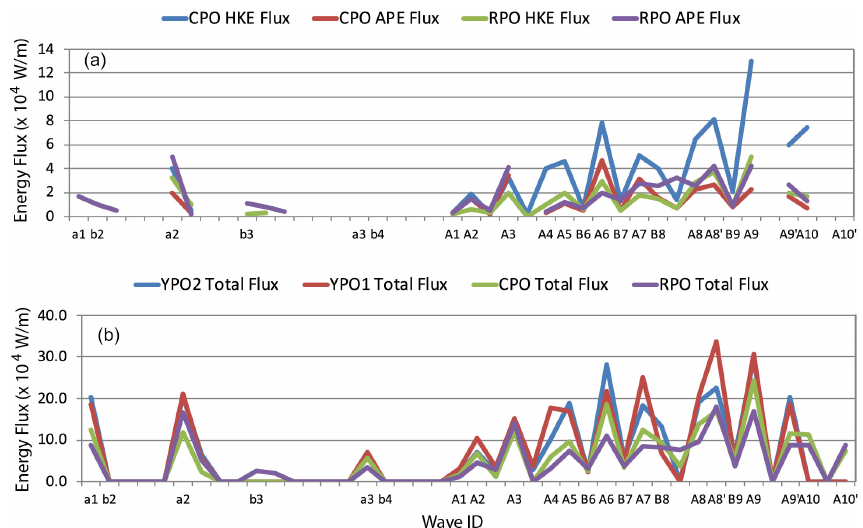
Figure 16. The energy fluxes up the slope for each of the nonlinear internal waves identified in the sand dunes moored array data. (a) The kinetic and potential energy flux for moorings CPO and RPO. (b) The total energy flux for all four moorings. This is the sum of the kinetic, potential, and pressure work